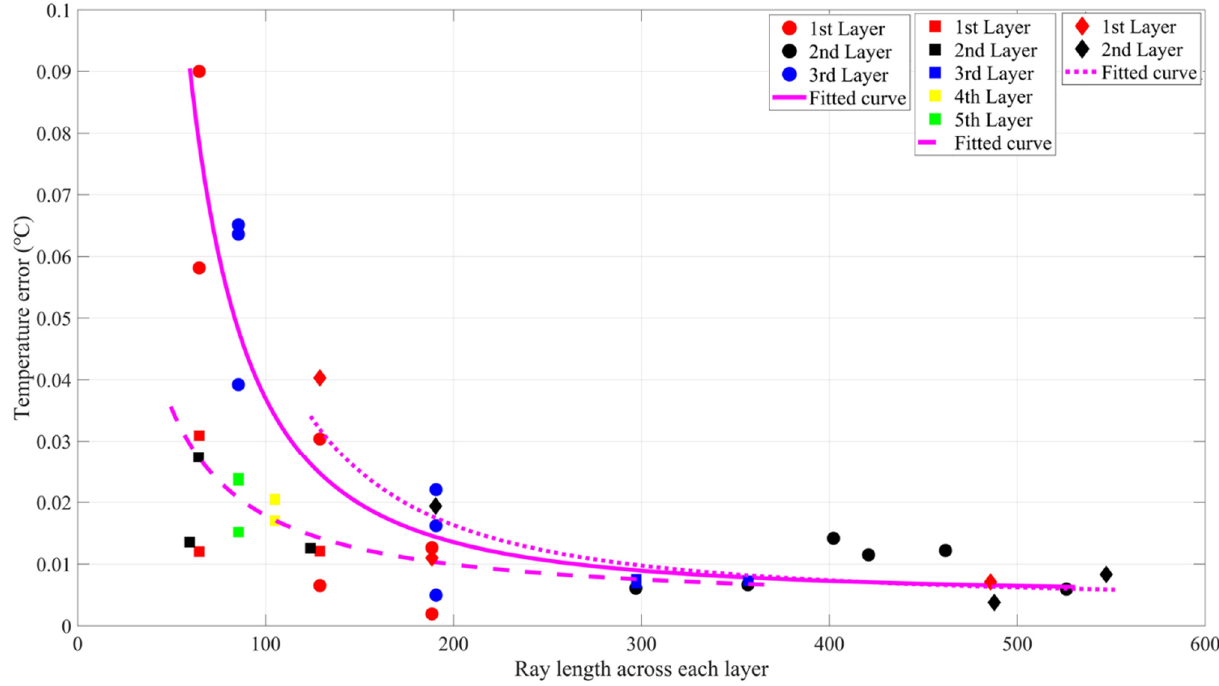
Figure 17. Relationship between the ray length across each layer and inversion errors of S2–S3. Three layers: Red, black, and blue circles denote the errors of the first layer, the second layer, and the third layer, respectively. The magenta curve indicates the fitted curve by using the power function. Five layers: Red, black, blue, yellow, and green squares denote the errors of the first layer, the second layer, the third layer, the fourth layer, and the fifth layer, respectively. The magenta dotted curve indicates the fitted curve by using the power function. Two layers: Red and black diamonds denote the errors of the first layer and the second layer, respectively. The magenta dotted curve indicates the fitted curve by using the power function.